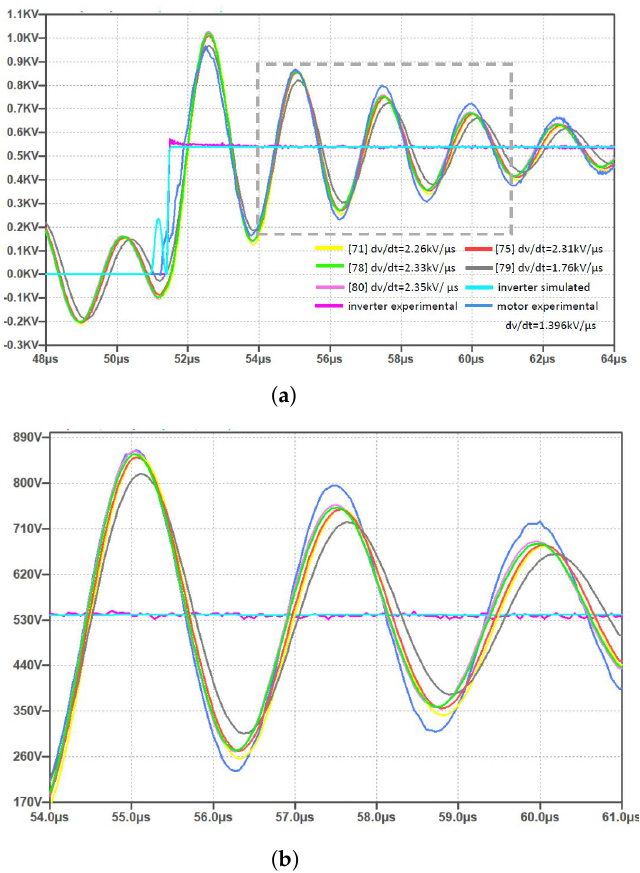
Figure 21. Comparison between the experimental voltage at motor terminals and voltages of different HF models for 32 kHz switching frequency and 30 m long lead ( a ) the whole waveform and ( b ) zoom indicated in ( a